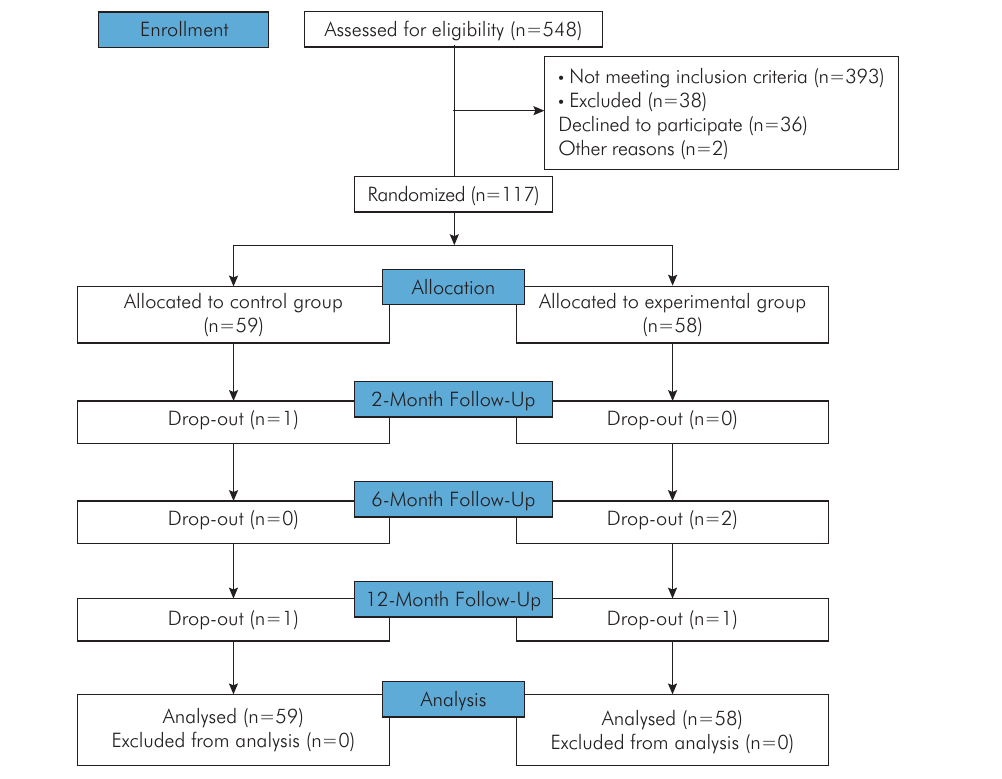
Figure 1. CONSORT flowchart of the participants’ progress through the trial